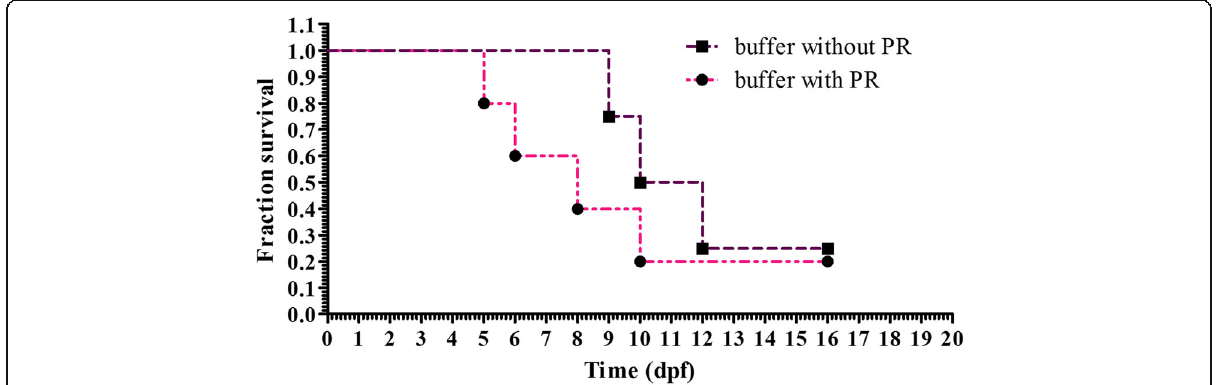
Fig. 6 Survival curve of larvae exposed to buffer in the presence and absence of phenol red. PR, phenol red